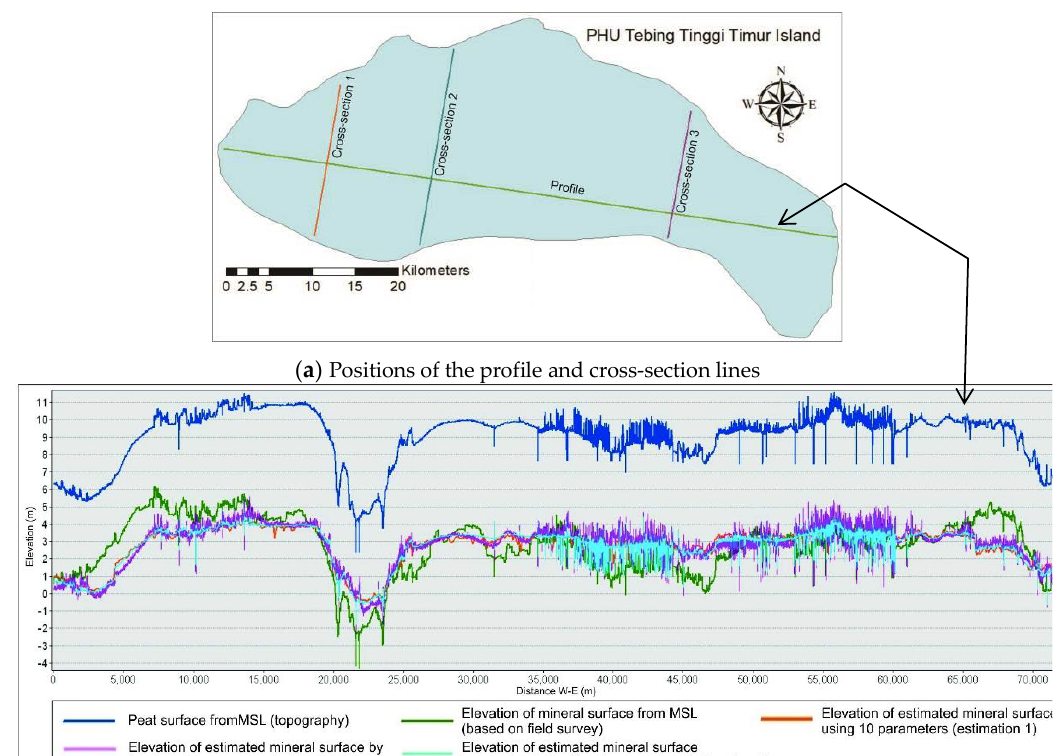
Figure 7. (a) Positions of the profile line and (b) the longitudinal profile view along the profile line. Note: cross-section 1, cross-section 2, and cross section 3 can be seen in Appendix A1. The estimation 1 (orange) line pattern shows a less suitable trend compared to the real mineral line (green), which is caused by the different resolutions of the input layer. The estimation 2 (pink) profile shows another pattern (compared to estimation 1 and estimation 3), which has the opposite direction to the actual direction of mineral soil elevation. The estimation 3 (light blue) profile is a model result that only involves significant parameters that pass statistical testing. It shows a generally smoother line compared to estimation 1 and estimation 2 patterns. Overall, the generated profile seems to generally follow the real mineral lines. There was some insignificant parameter elimination despite its invisible effect in the numerical calculation. However, it is visible in the profile (pattern).